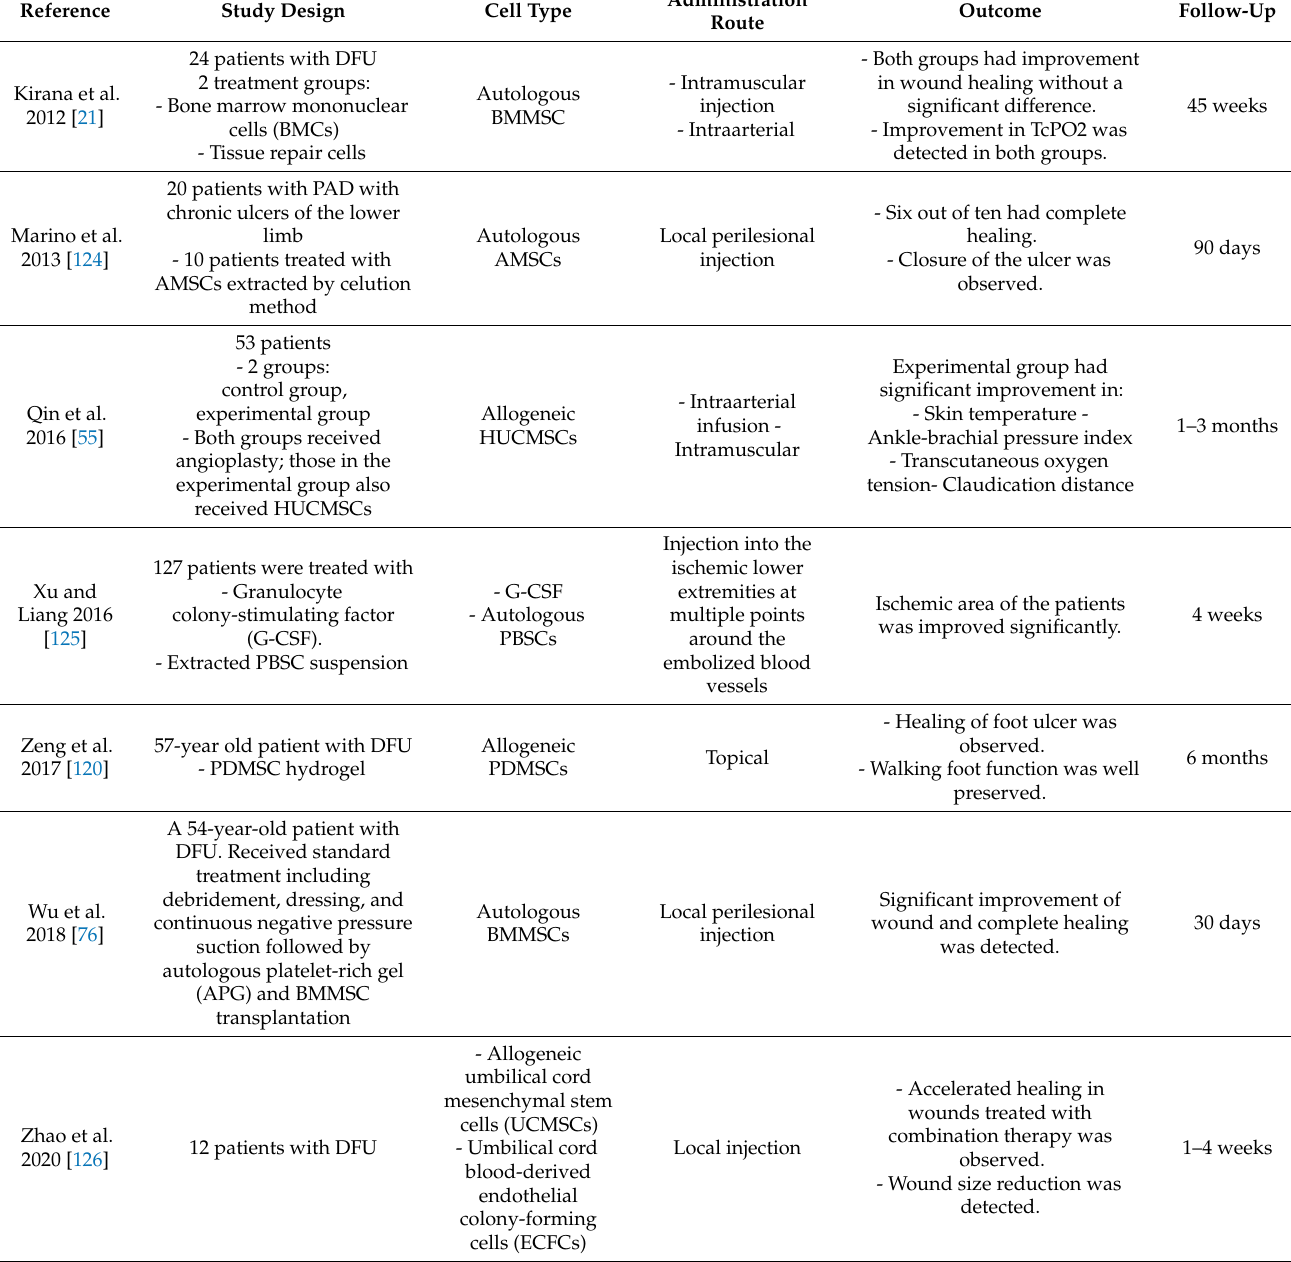
Table 1. Stem cell therapy for DFU in clinical